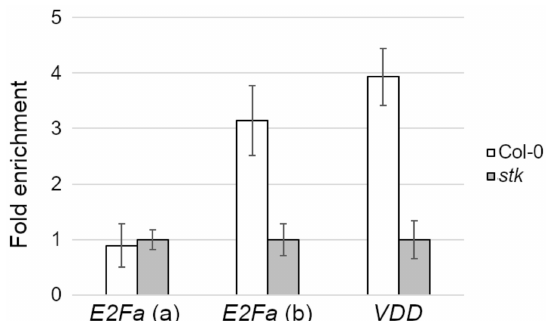
Figure 3. Chromatin immunoprecipitation (ChIP) enrichment by q-PCR of the STK binding site on E2Fa . Region “b” of E2Fa (see Supplementary Figure S2) is directly bound by STK during seed development, while region “a” is not. VERDANDI ( VDD ) was used as positive control. The q-PCR was conducted in duplicates. Fold enrichment was calculated over the negative controls. Error bars represent the propagated error value using three replicates.